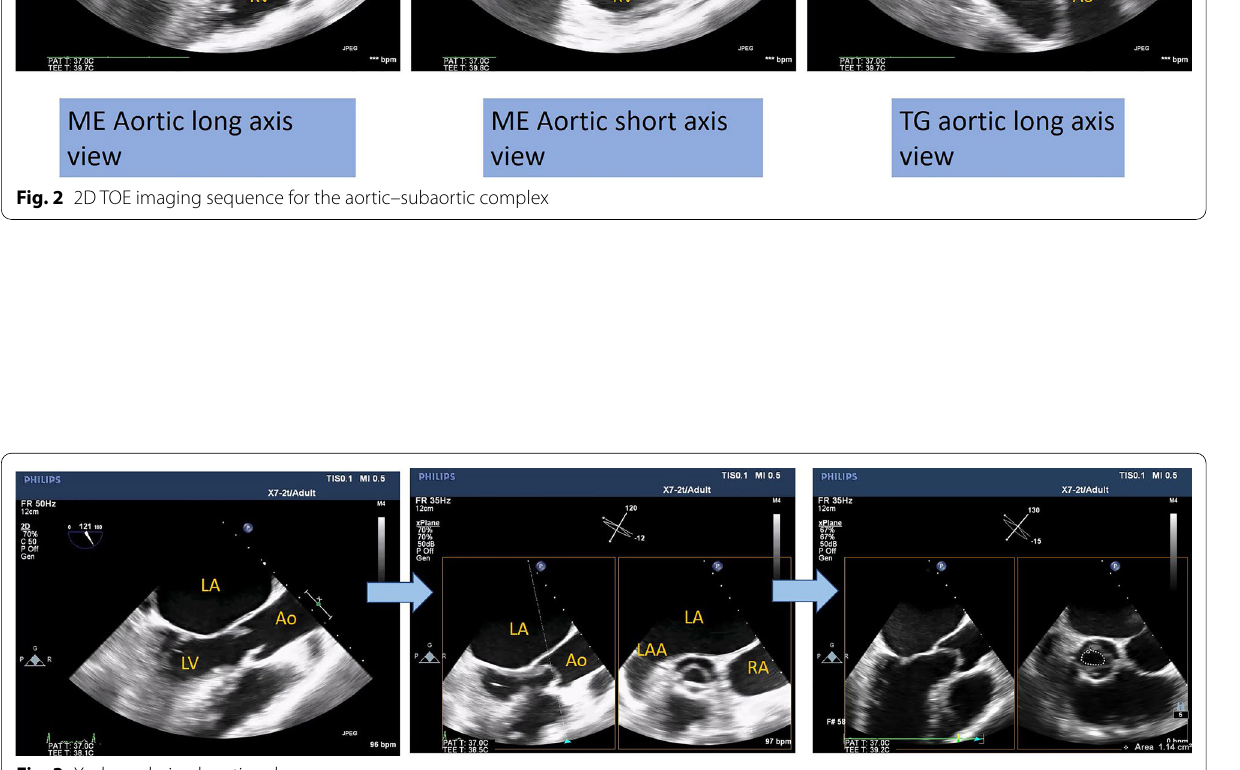
Fig. 3 X‑plane‑derived aortic valve